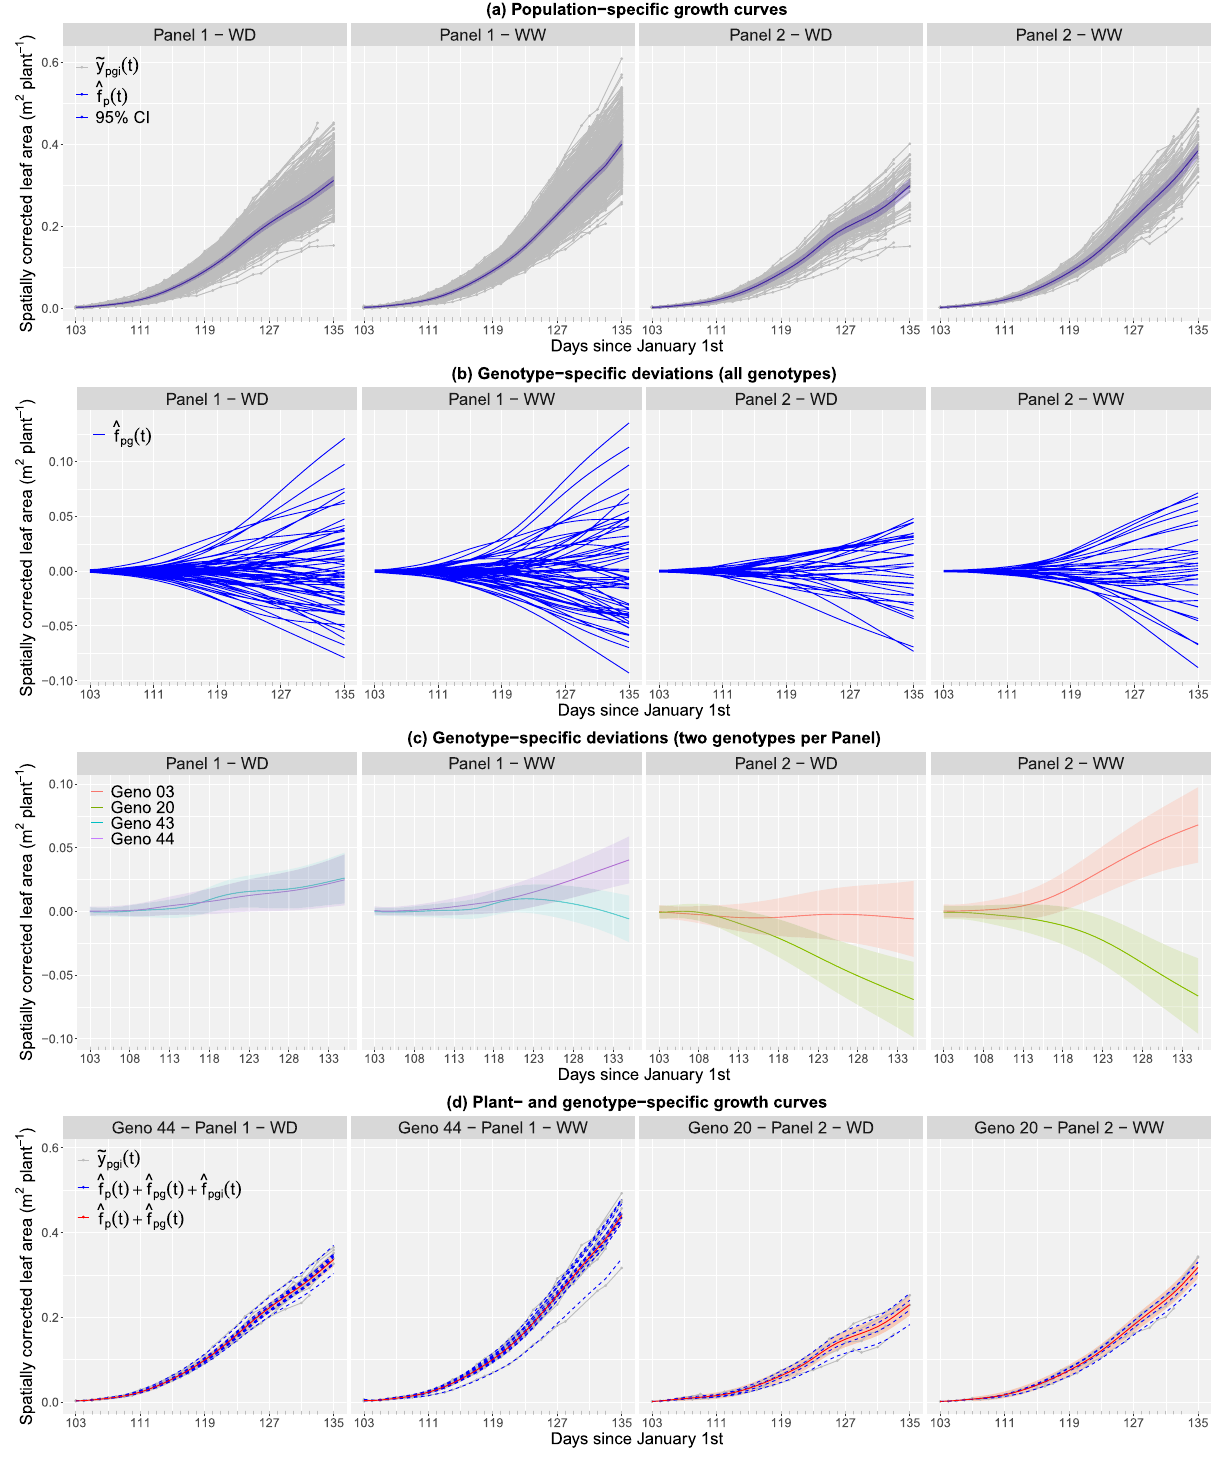
Figure 4. Results of the second stage of analysis for the PhenoArch platform: ( a ) Estimated population growth curves (continuous blue lines) with 95% pointwise confidence intervals (blue shaded areas), ( b ) estimated genotype-specific deviations for all genotypes, ( c ) estimated genotype-specific deviations for two genotypes per population (as illustration) with 95% pointwise confidence intervals (shaded areas); and ( d ) estimated plant- (dotted blue lines) and genotype- (red continuous lines) specific growth curves with 95% pointwise confidence intervals (red shaded areas) for two genotypes, one per panel, under the two water regimes (as illustration). WD stands for water deficit and WW for well watered. In ( a ) and ( d ) the grey lines represent the spatially corrected leaf area at the plant level (first